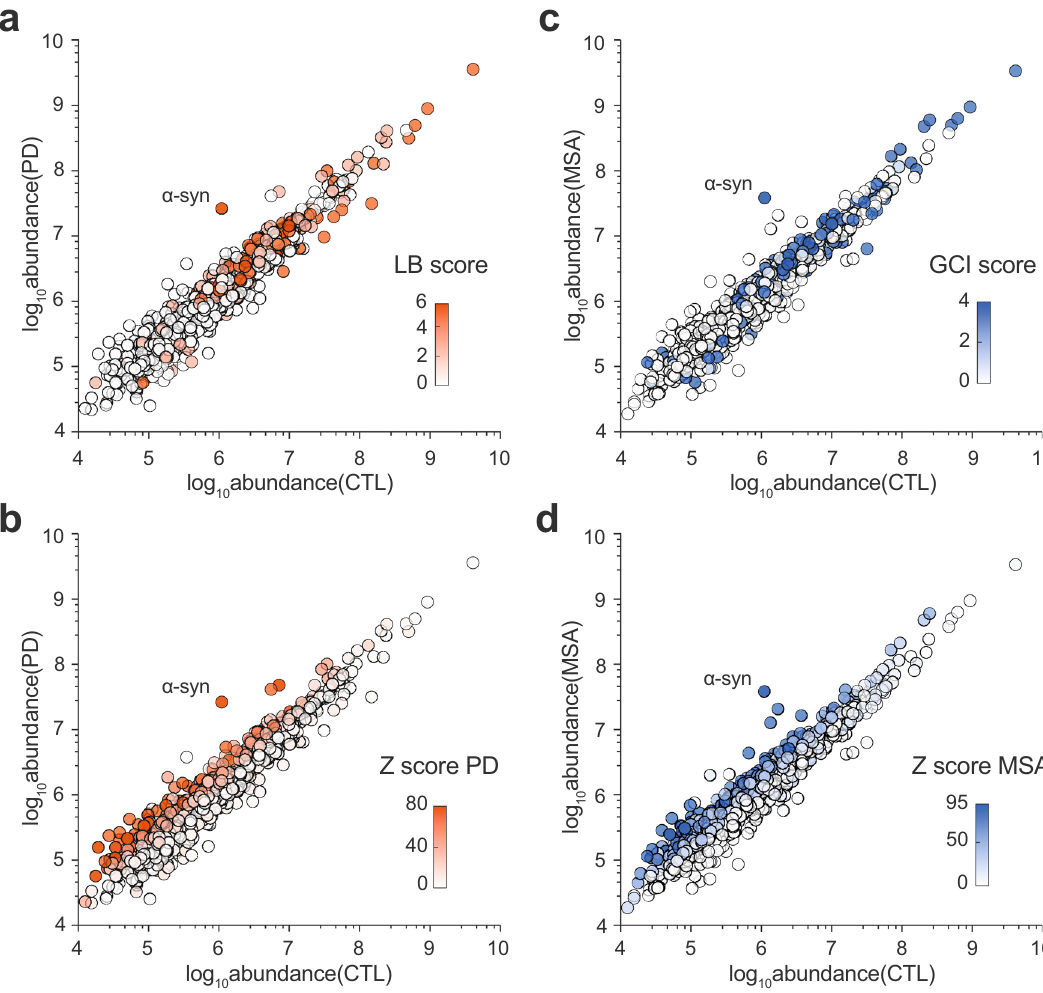
Fig. 3 Identi fi cation and resolution of synucleinopathy insoluble proteomes independently of the physiological abundance of proteins. Spear charts representing mass spectrometry analysis of the protein content of all n = 9 Sarkospin pellets. Each of the 1022 master proteins identi fi ed in the present proteomic study is plotted as a circle positioned upon the total abundance of the protein (log 10 Abundance, A.U.) in control samples and its total abundance in PD ( a , b ) and MSA ( c , d ) samples. a , c Spear charts are respectively color-coded upon the protein LB and GCI scores described in Fig. 2. b , d Spear charts are color-coded respectively upon the protein Z score for PD and MSA, with Z = FC × ( − log 10 p ) for each disease